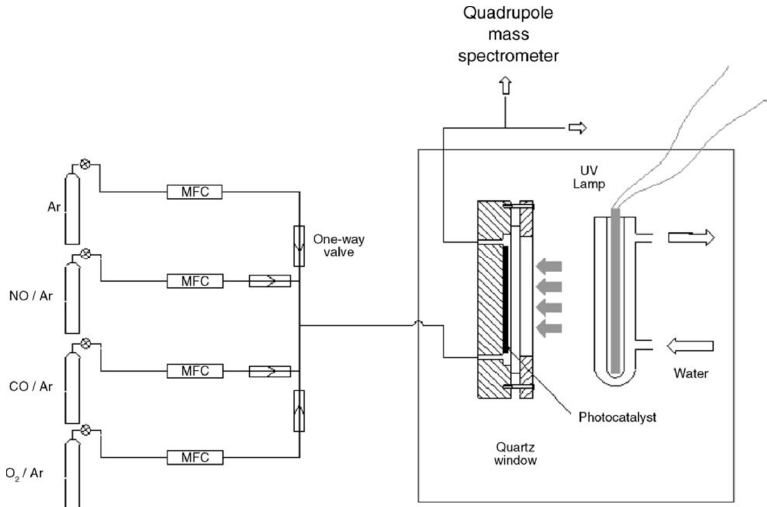
Figure 25. Schematic of the photoreactor used for testing the photocatalytic behavior of the various P-25 TiO 2 catalytic samples (see text). Reproduced with permission from Bowering et al. [109]. Copyright 2005 by Elsevier B.V. (License No.: